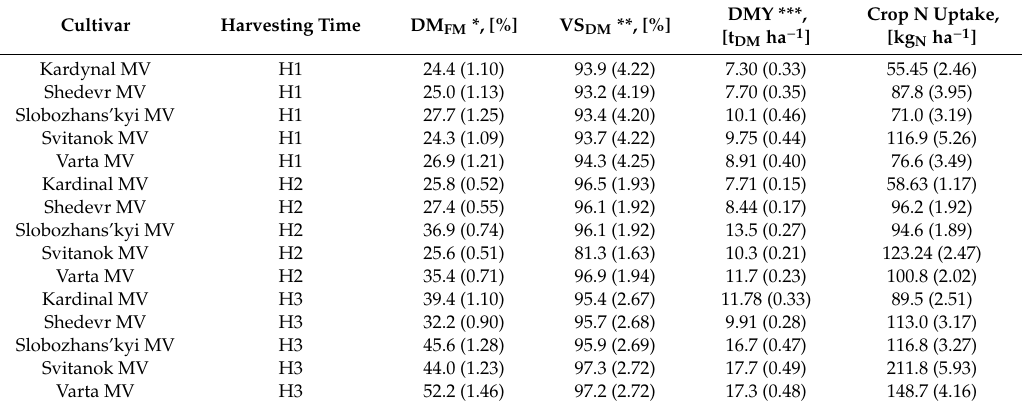
Table 3. Maize: DM and VS- content at harvest time, dry matter yield per hectare and N-uptake. Units are given in square brackets. Values are given as mean; standard deviation is given in round brackets. Cultivar